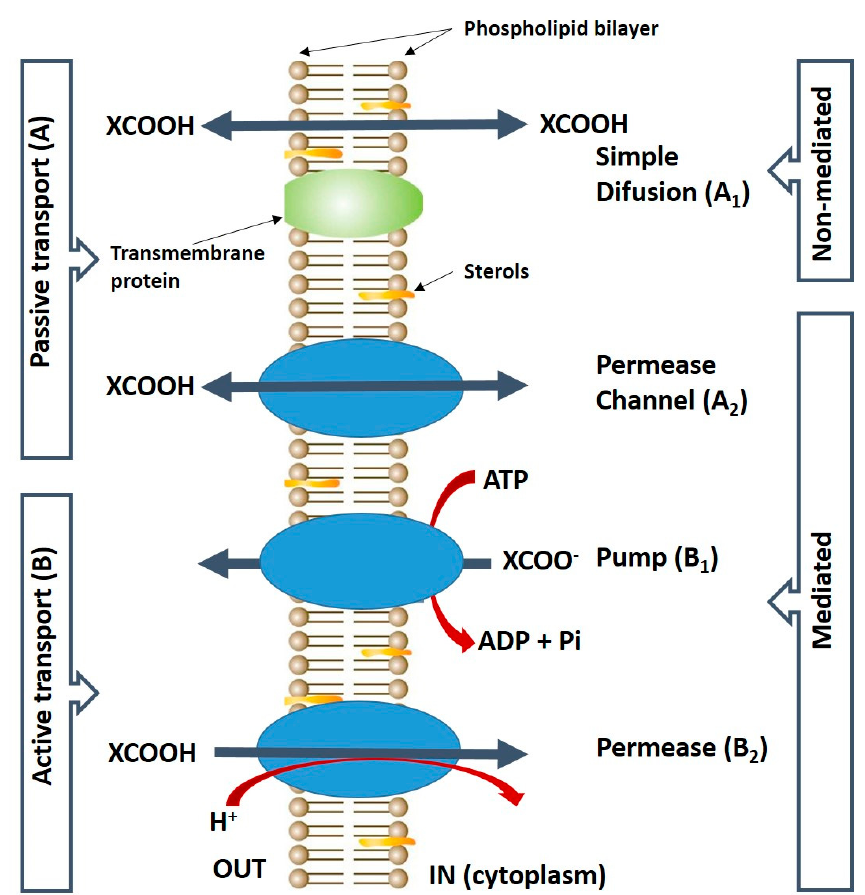
Figure 2. Schematic representation of the carboxylic acids transport systems in the yeast cell membrane: Carriers (transporters) are represented by the three blue-oval shapes; XCOOH, carboxylic acid. XCOO − , anion form of the acid. Adapted from Casal et al. [34].